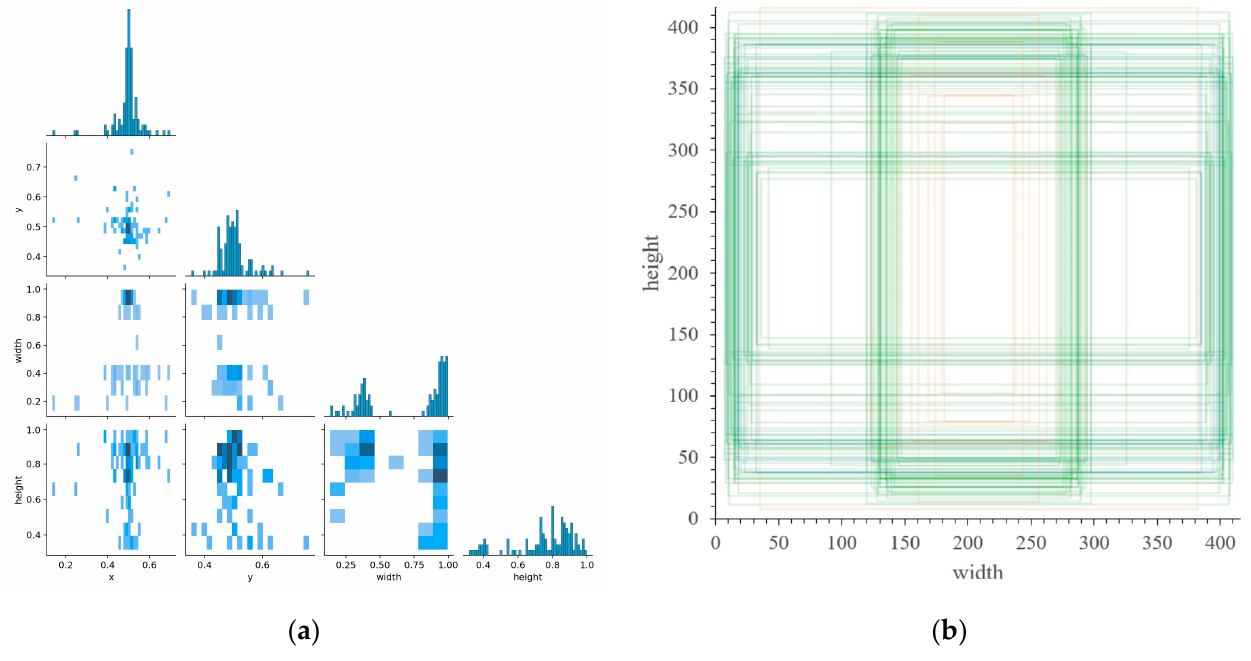
Figure 2. The distribution of all ground truth bounding boxes. ( a ) the length and width information of all ground truth bounding boxes and ( b ) the real size and shape of all ground truth bounding boxes.